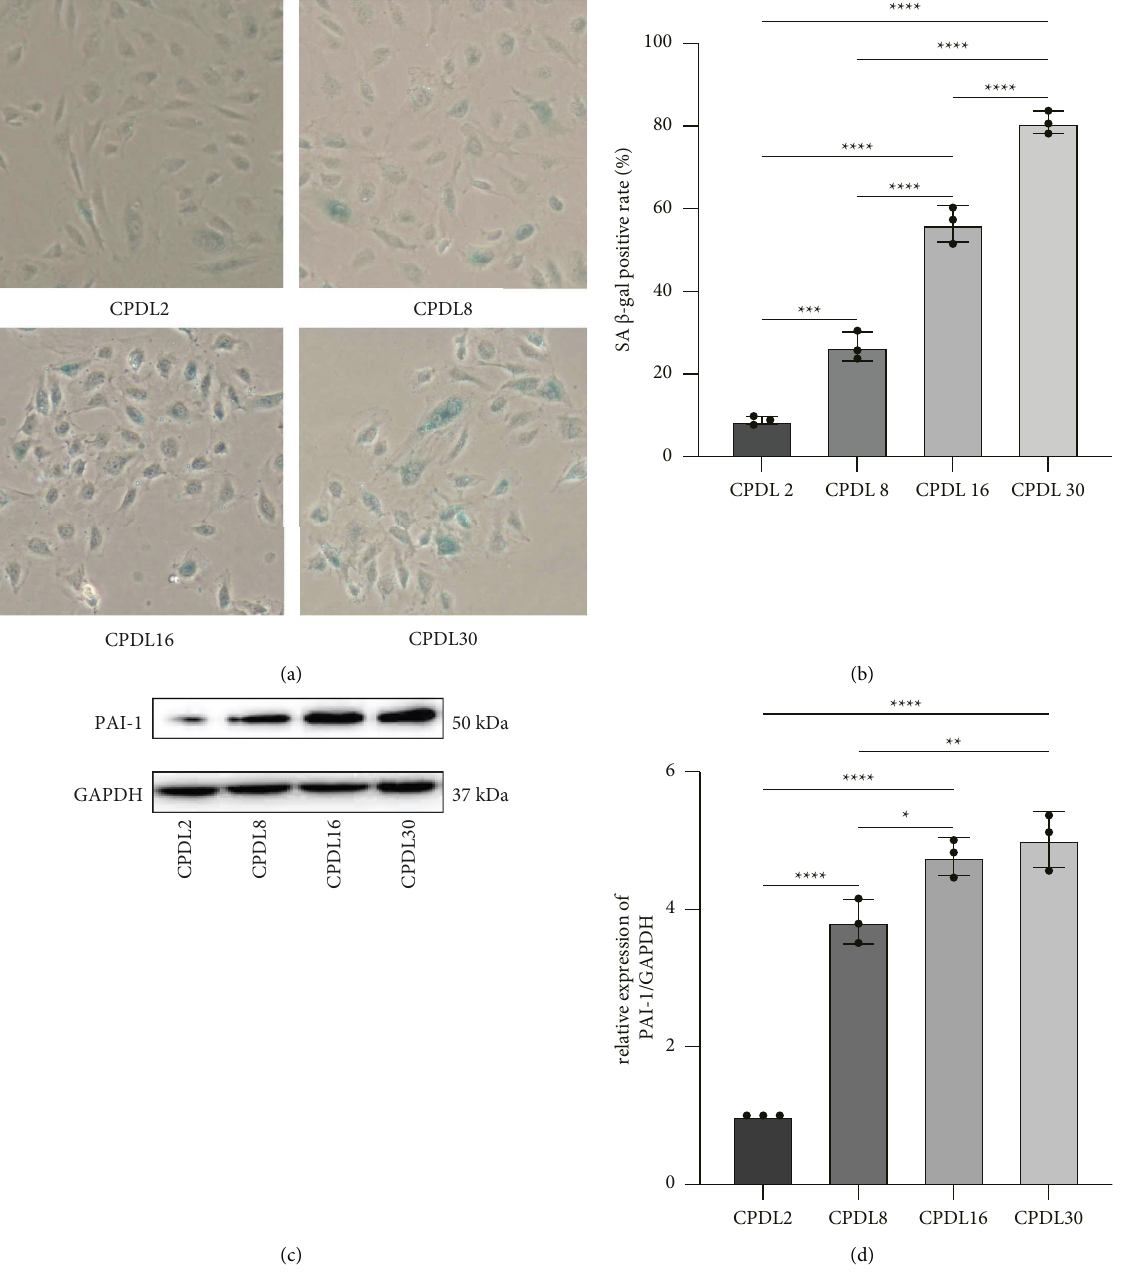
Figure 4: Establishment of replicative senescence model in HUVECs. SA- β -Gal staining (a) and the statistics (b) of HUVECs at diferent CPDLs (100 × ). Senescent cells were stained blue. Te CPDL 8, 16 and 30 groups showed a signifcant increase SA- β -Gal level as compared with the CPDL 2 group. n � 3 per group. ∗∗∗ P < 0 . 001, ∗∗∗∗ P < 0 . 0001 by LSD-t test after ANOVA. Te expression of PAI-1 of HUVECs at diferent CPDLs as detected by western blot (c) and its statistics (d) Te CPDL8,16, and 30 groups showed a signifcant increase of PAI- 1 protein expression compared to the CPDL 2 group. n � 3/group. ∗ P < 0 . 05, ∗∗ P < 0 . 01, ∗∗∗∗ P < 0 . 0001 as detected by LSD-t test after